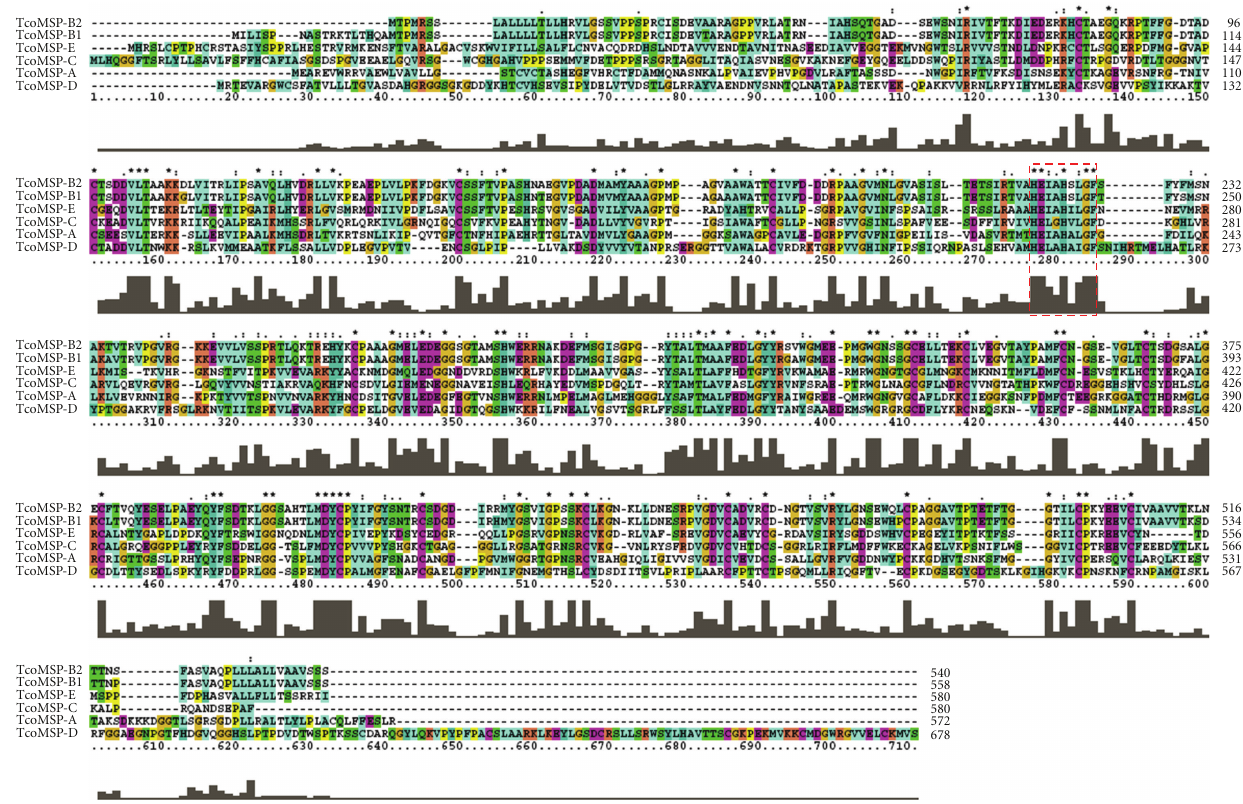
Figure 1: Multiple sequence alignment of T. congolense MSP homologues. The predicted amino acid sequences for each T. congolense MSP homologue were aligned to each other using the ClustalW alignment tool. Output was directly generated using ClustalX for Windows. The dashed red box indicates a conserved motif shown to be essential for Zn 2+ binding in related